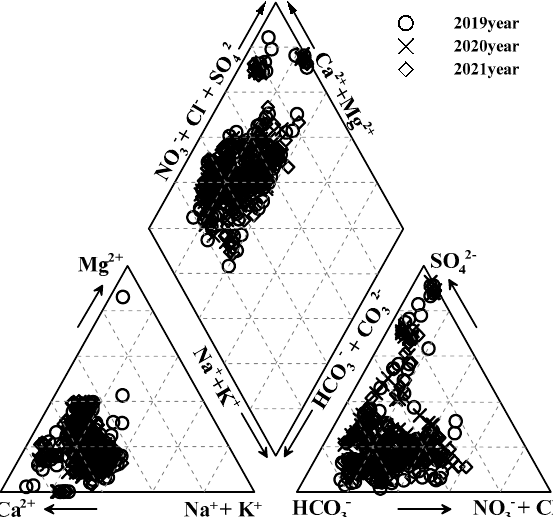
Figure 4. Groundwater type in monitored sites.